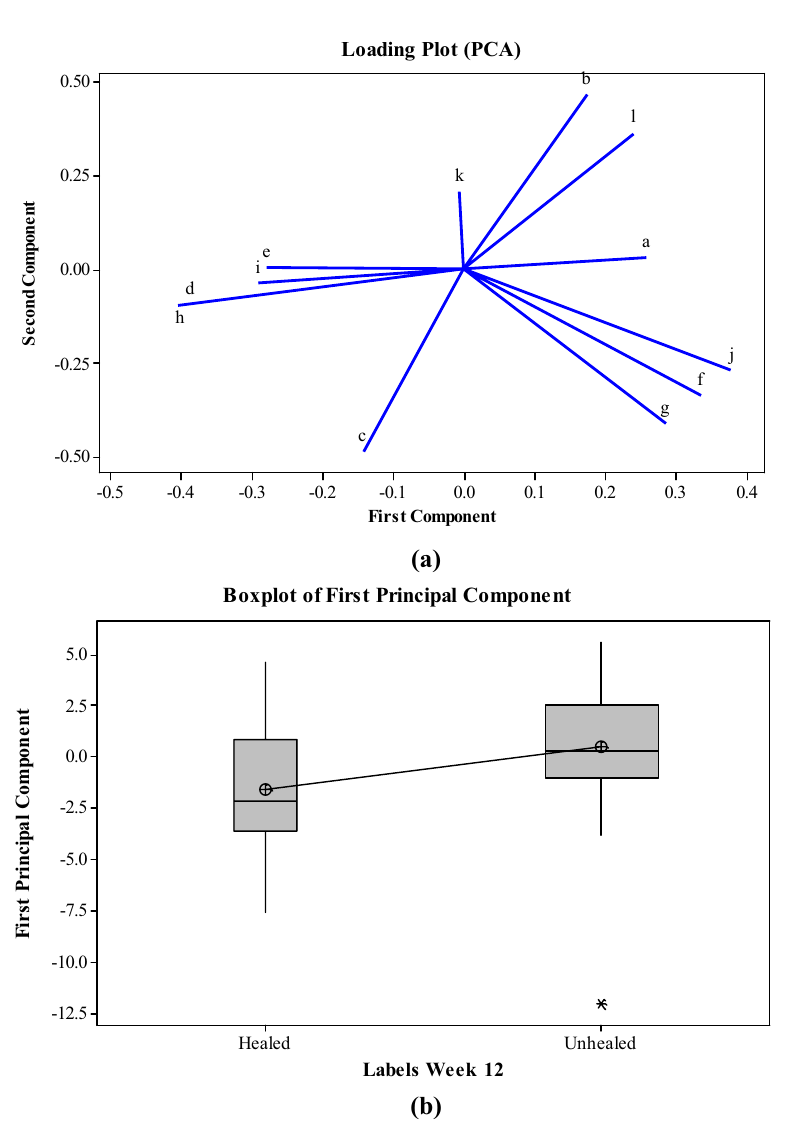
Figure 1. ( a ) loading plot of PCA, the letters/notations shown for each variable correspond to textural features explained in section “pre-processing and texture analysis” under item 7 ( b ) Box plot of first principal